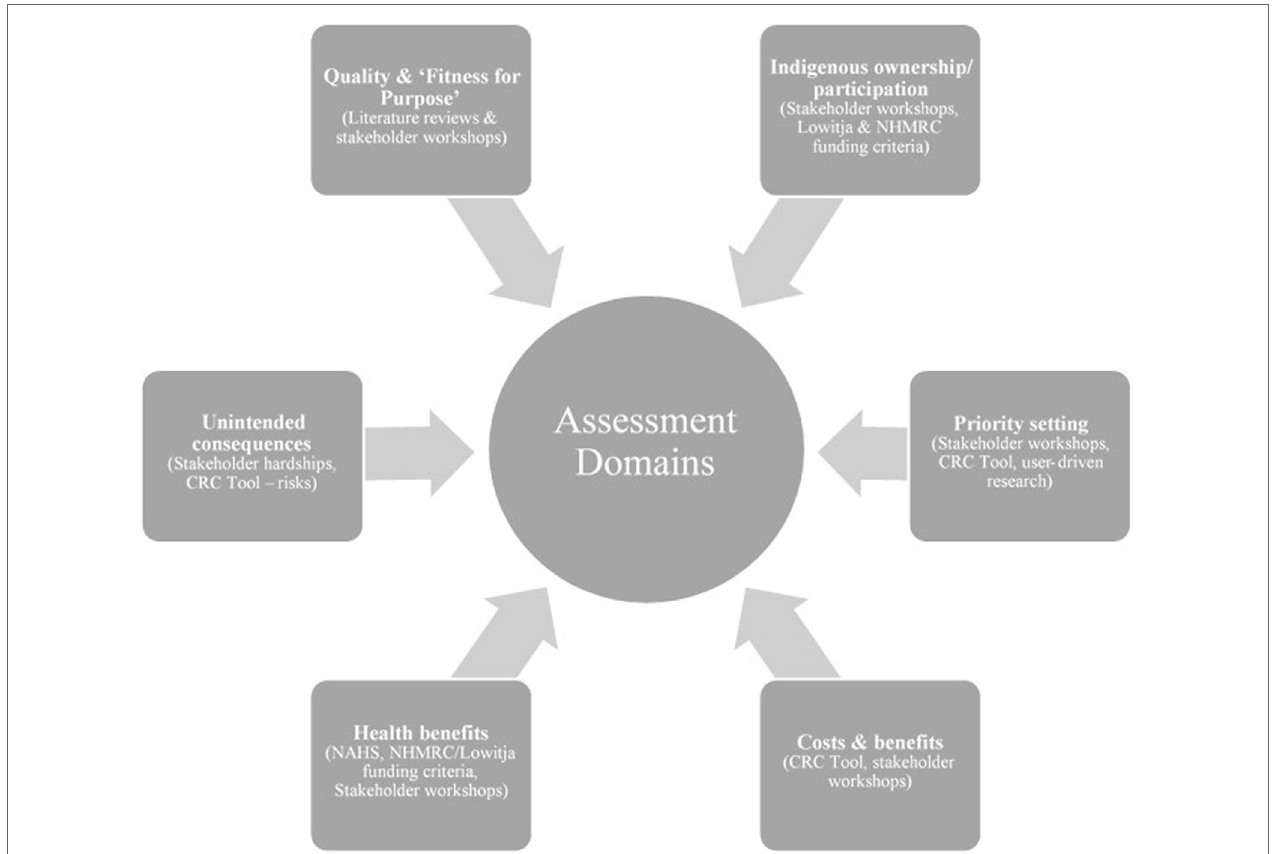
FigUre 1 | impact assessment domains